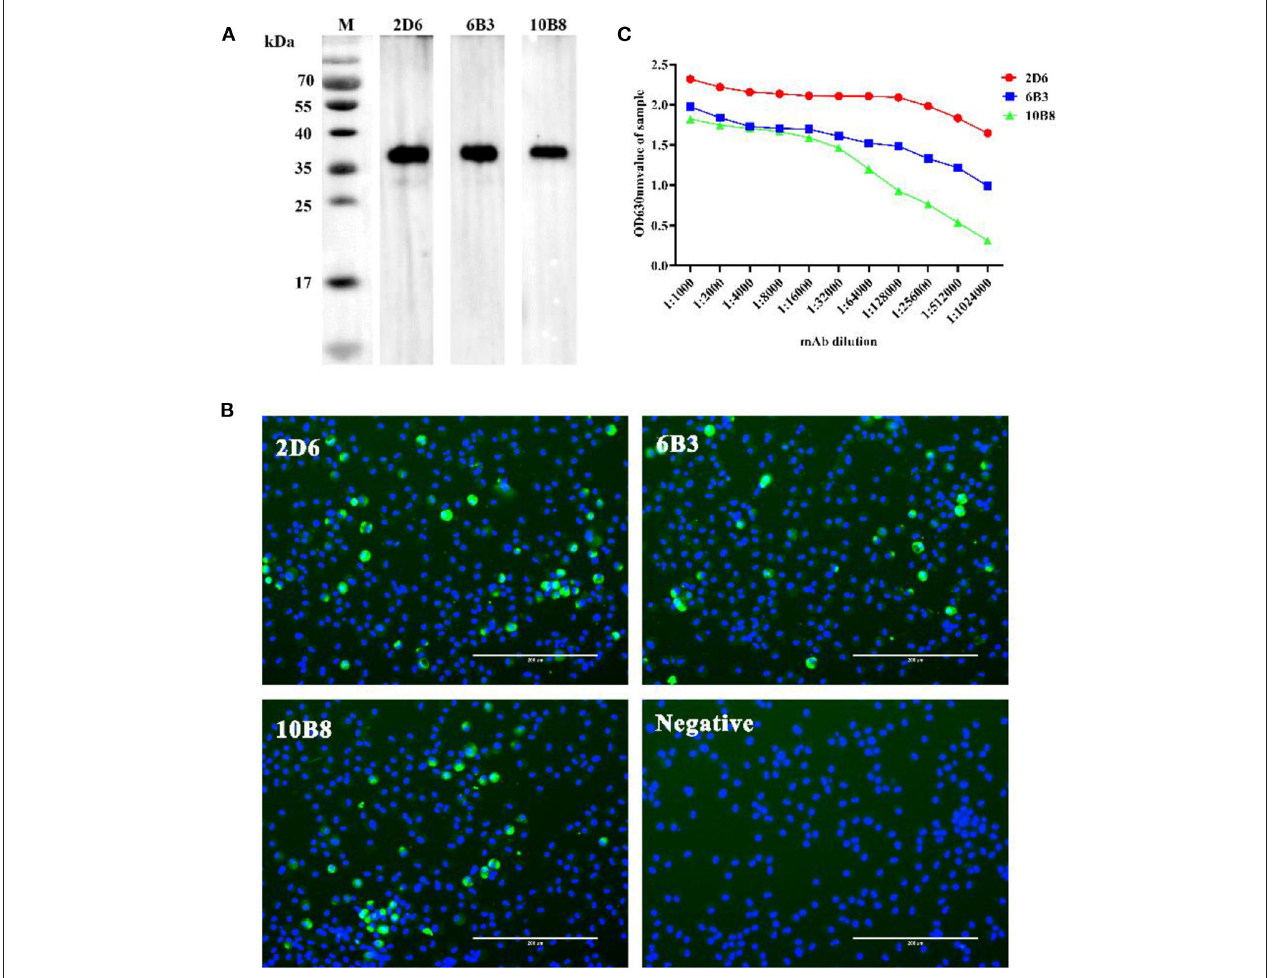
FIGURE 2 | Selection of p30-specific mAb for use in blocking ELISA. (A) Western blot analysis anti-p30 mAbs. The three anti-p30 monoclonal antibodies can react specifically with recombinant protein at 36 kD (Black). (B) IFA performed on PAMs that were infected with ASFV. Cells were incubated with p30-specific mAbs listed on the top of each panel and stained with FITC-conjugated goat anti-mouse IgG (Green). Cell nucleus was counterstained with DAPI (Blue). Scale bars, 200 µ m. (C) Different mAbs titer test results. The OD value of mAb-2D6 (Red) at any dilution is higher than mAb-6B3 (Blue) and mAb-10B8 (Green). It is shown that mAb-2D6 has the highest antibody